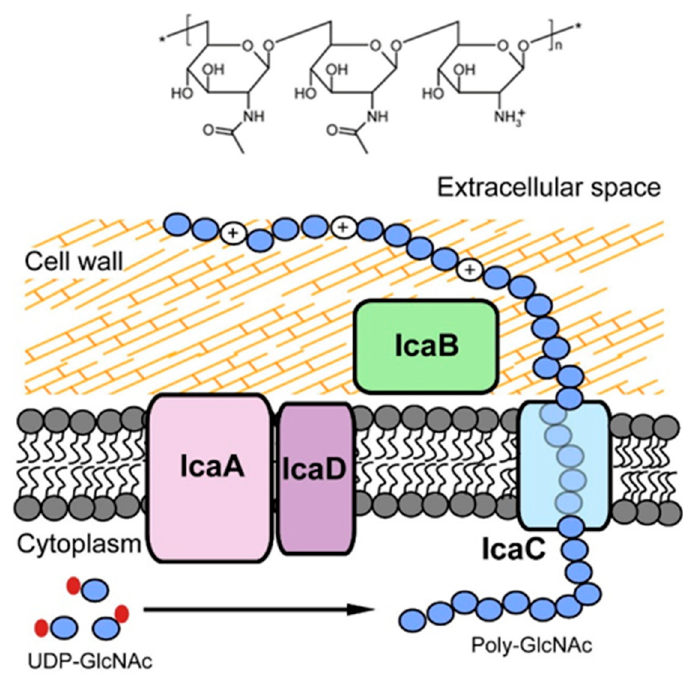
Figure 7. Chemical structure of PNAG (top) and the Ica system (bottom), which is responsible for the synthesis, translocation and deacetylation of PNAG. Adapted with permission from Nguyen et al. [119]. 2020, Elsevier.